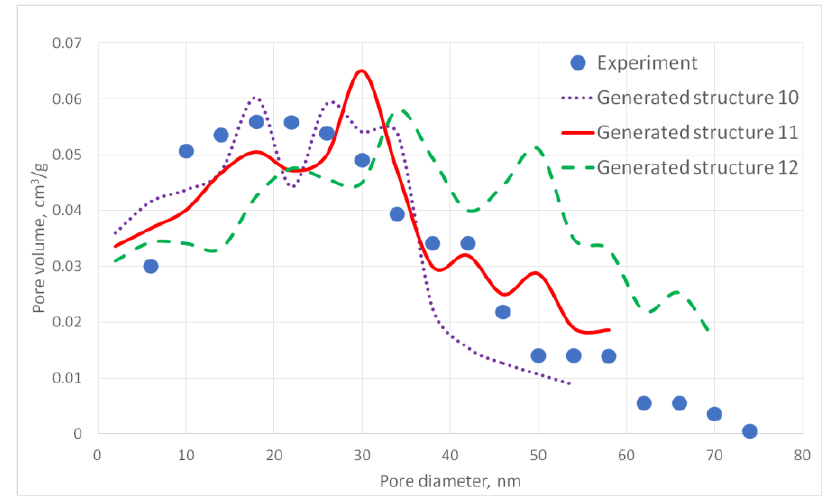
Figure 4. Pore size distribution curves for generated PA structures 7–9.